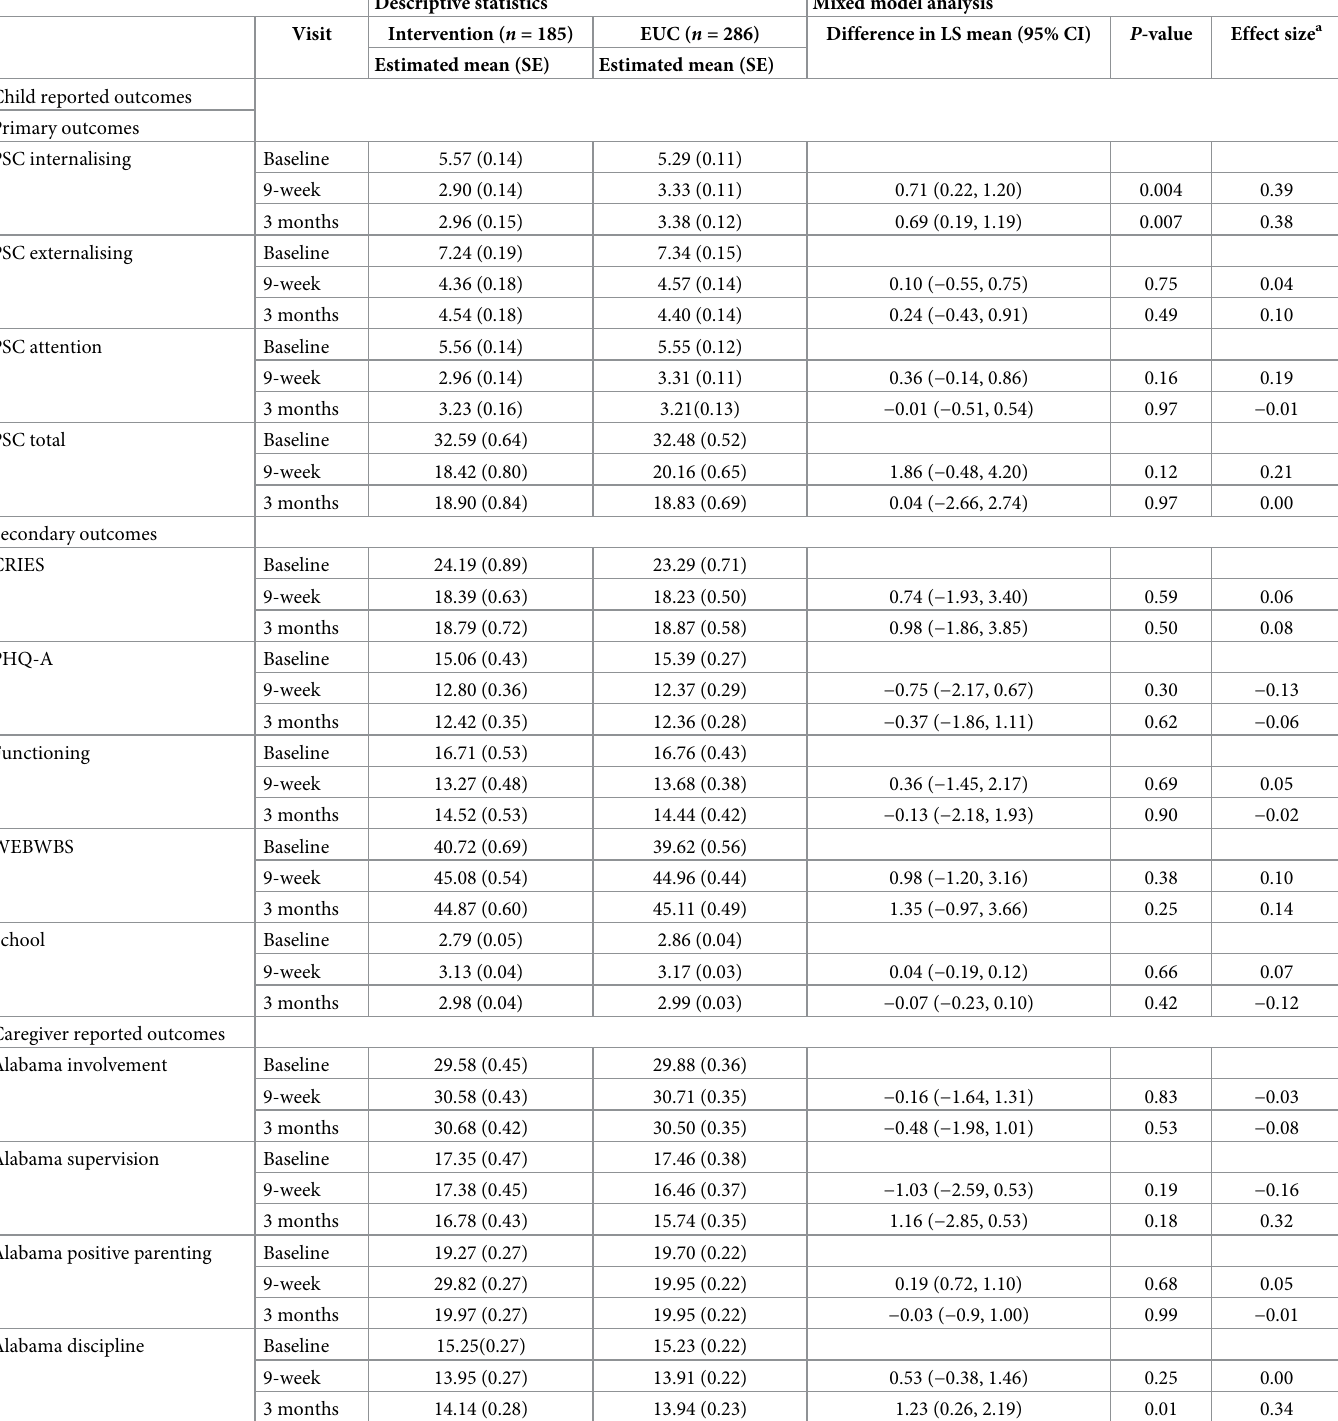
Table 3. Summary statistics and results from mixed model analysis of primary and secondary